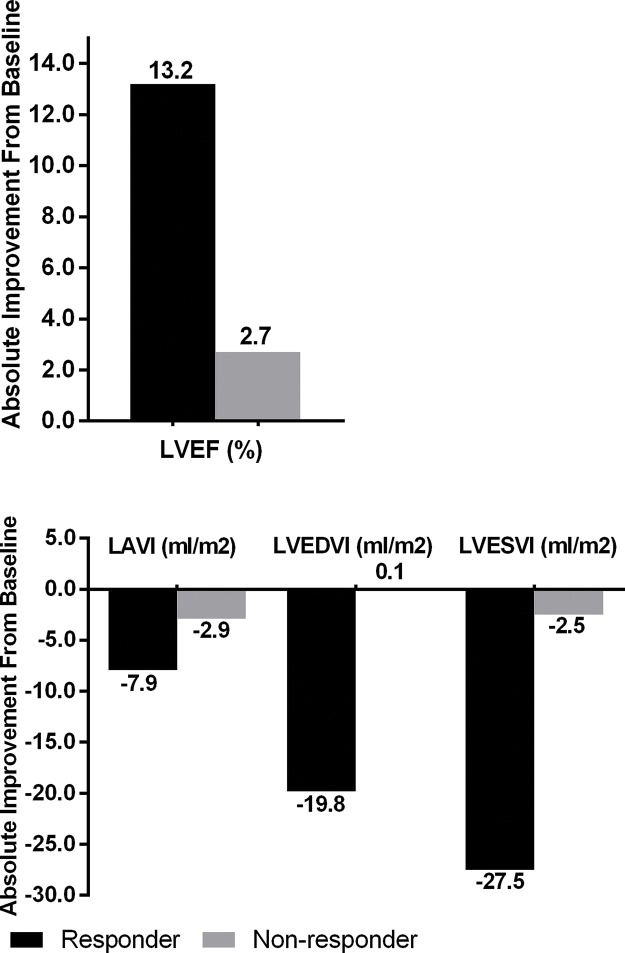
Changes in echocardiographic parameters in responder and nonresponder groups.